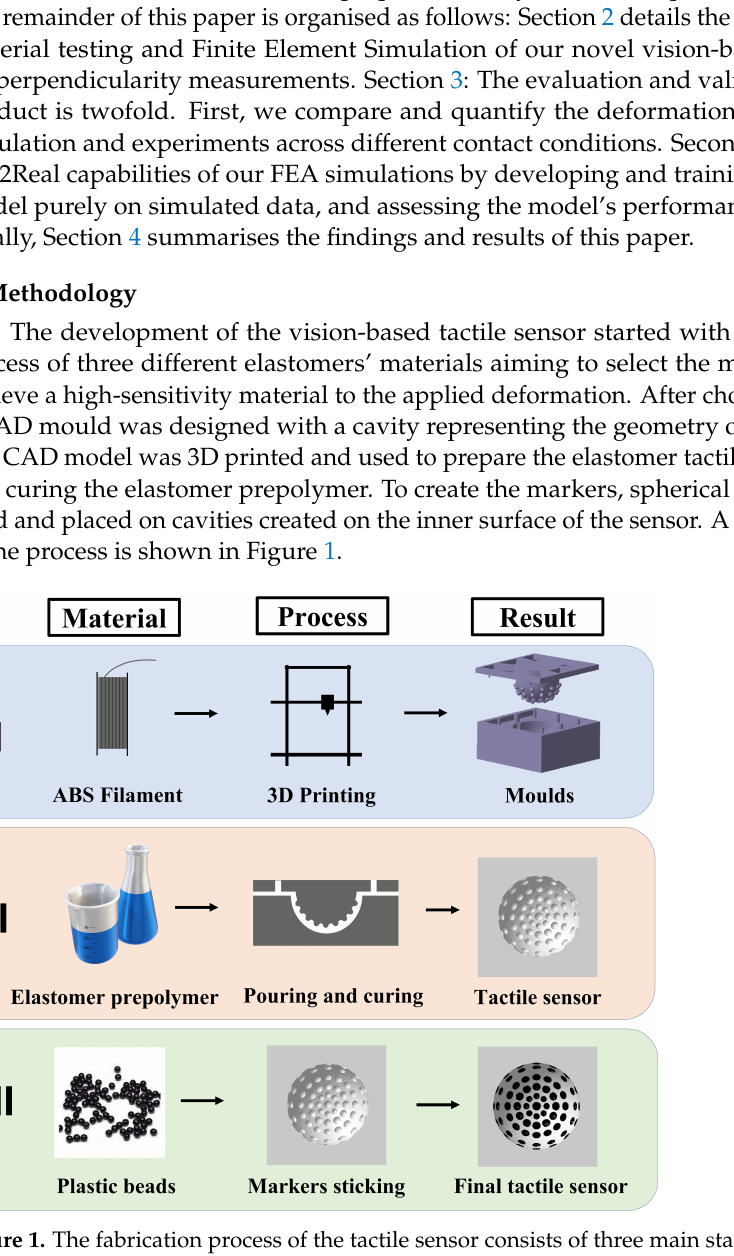
Figure 1. The fabrication process of the tactile sensor consists of three main stages: ( I ) ABS material is used in an FDM 3D printer to fabricate the upper and lower moulds. ( II ) Liquid silicon material colored by silicon pigments is poured and cured in the 3D-printed mould. ( III ) Internal markers consisting of plastic beads are precisely sticked in the required